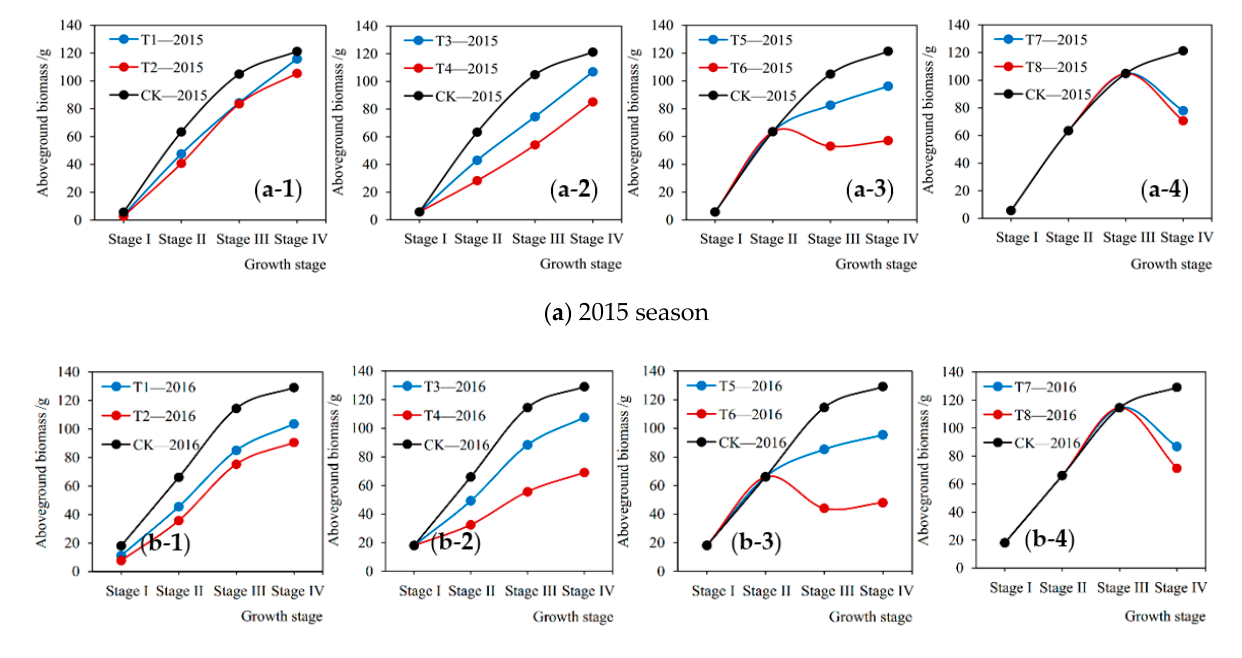
Figure 5. Aboveground biomass accumulation process of soybean plants at each growth stage under different treatments (T1–T8 and CK) in ( a ) 2015 season and ( b ) 2016 season. Stage I: seedling stage, Stage II: branching stage, Stage III: flowering-podding stage, Stage IV: seed-filling stage.